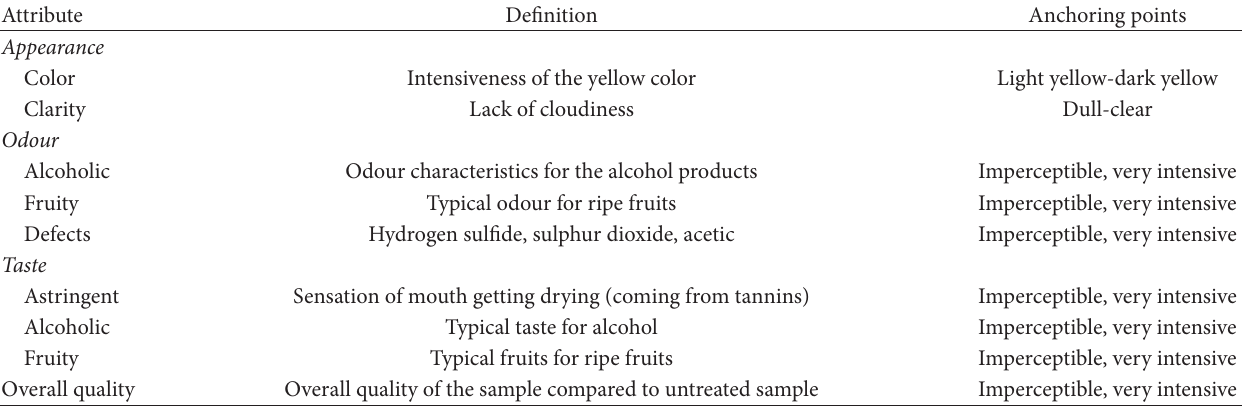
Table 1: Definitions and anchors of sensory attributes used in the descriptive analysis of HHP-treated wine.